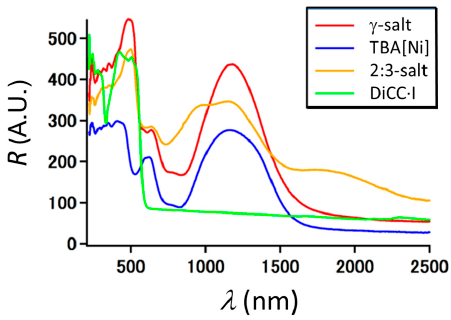
Figure A1. Diffuse reflectance spectra of γ - and 2:3-salts (powder). Spectra of [n-(C 4 H 9 ) 4 N][Ni(dmit) 2 ] (TBA[Ni]) and DiCC · I (both in powder) are also shown for comparison. Red; γ -salt, blue; [n-(C 4 H 9 ) 4 N][Ni(dmit) 2 ], yellow; 2:3-salt, green; DiCC · I.